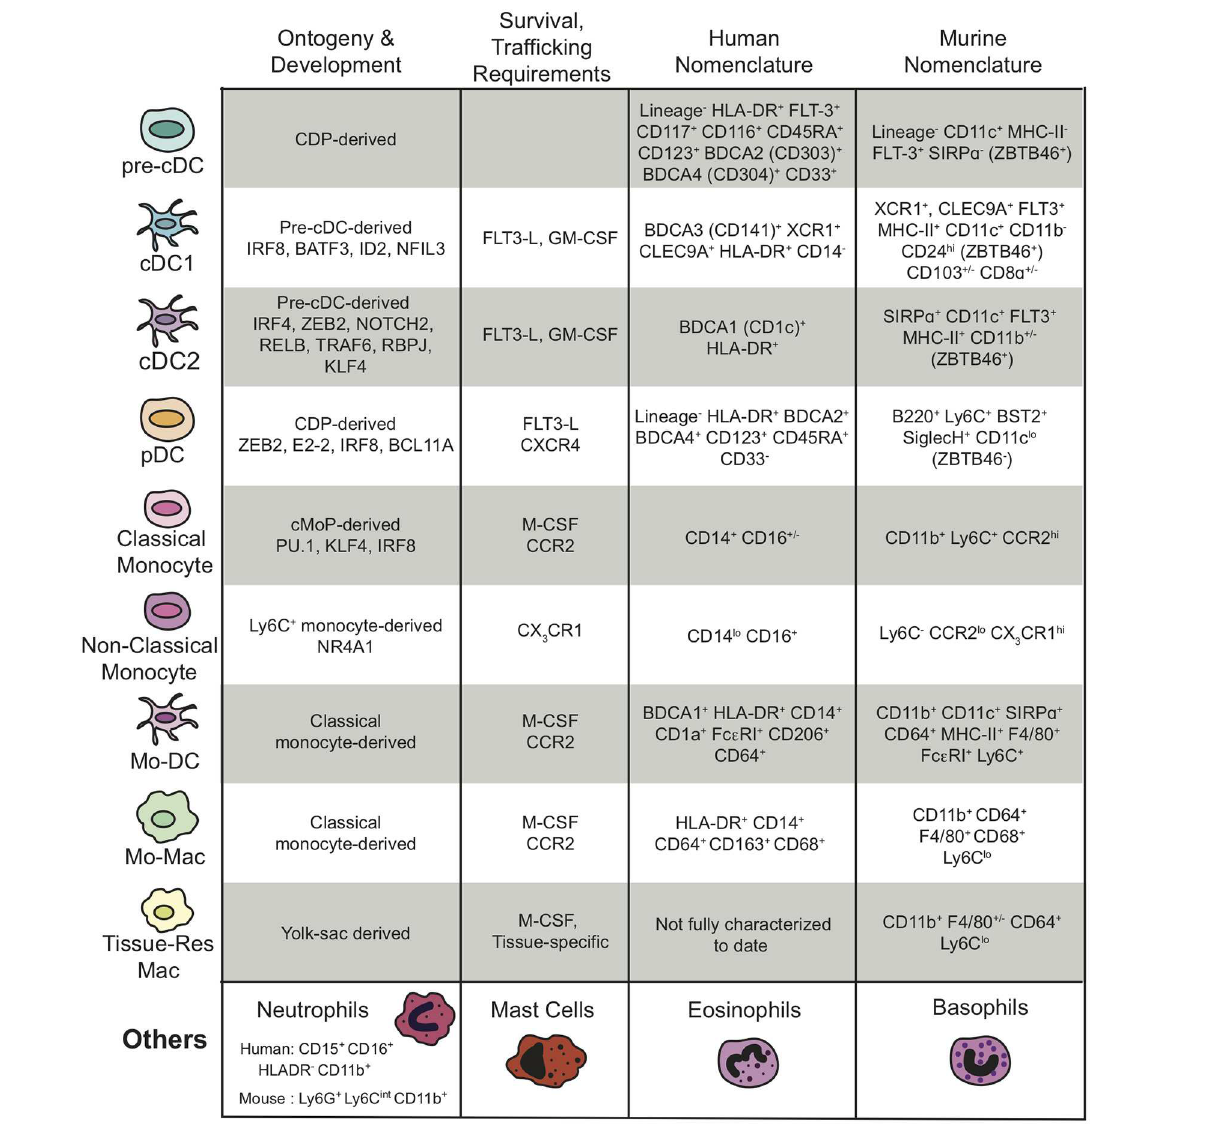
FIGURE 1 | Summary of the different subtypes of myeloid cells present in the TME, their ontogeny and development, their survival and trafficking requirements, and their human and mouse nomenclatures including transcription factors and cell surface markers. The “Others” myeloid cells in the last row represent the granulocytes. “Lineage − ” is defined as CD3 − CD14 − CD16 − CD19 − for the human nomenclature and CD3 − NKp46 − B220 − for the murine